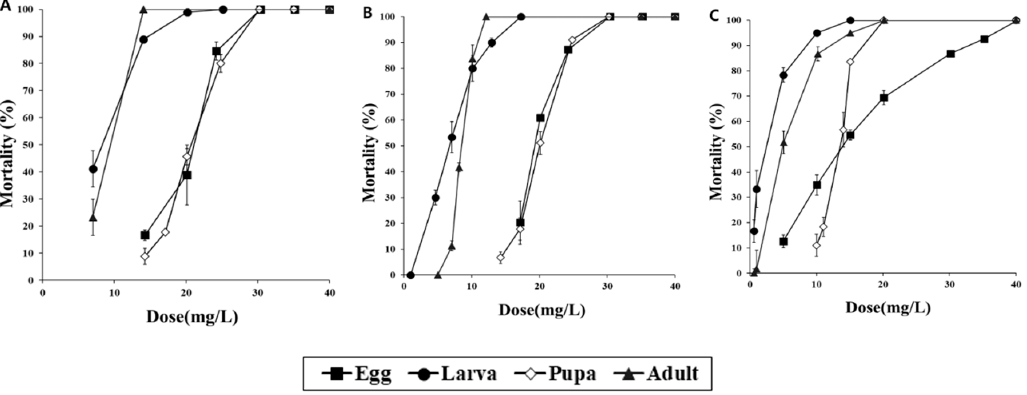
Figure 2. Mortality of r-strain Tribolium castaneum across all developmental stages after treatment with 2 mg / L PH 3 in a 12-L desiccator according to exposure time.